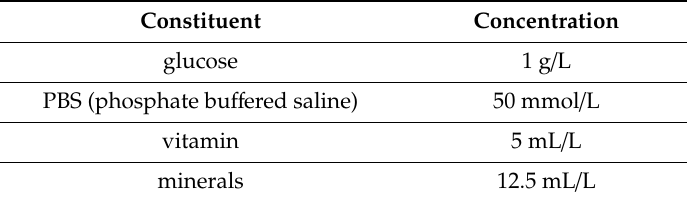
Table 1. Formulation of glucose solution.